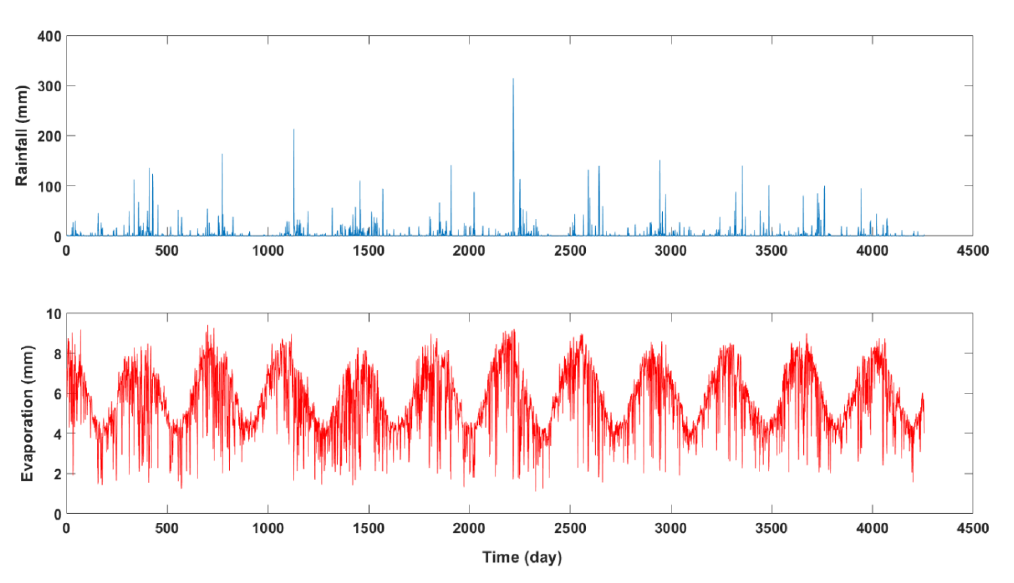
Figure 2. Rainfall and evaporation series of the studied site.